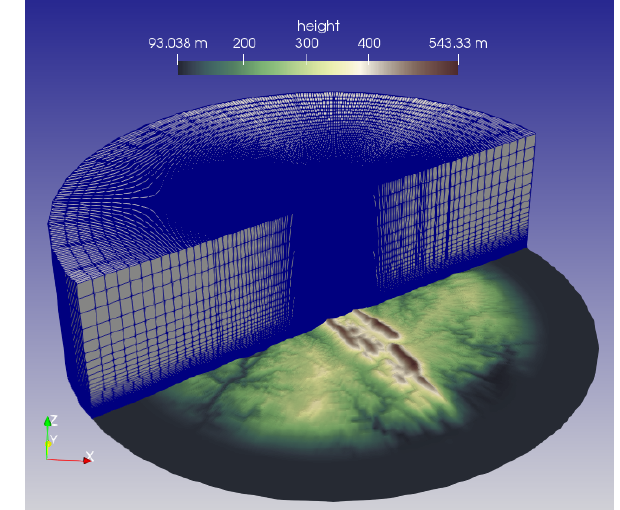
Figure 1. Mesh of E-Wind for a wind direction of 230 ◦ (inflow parallel to cutting